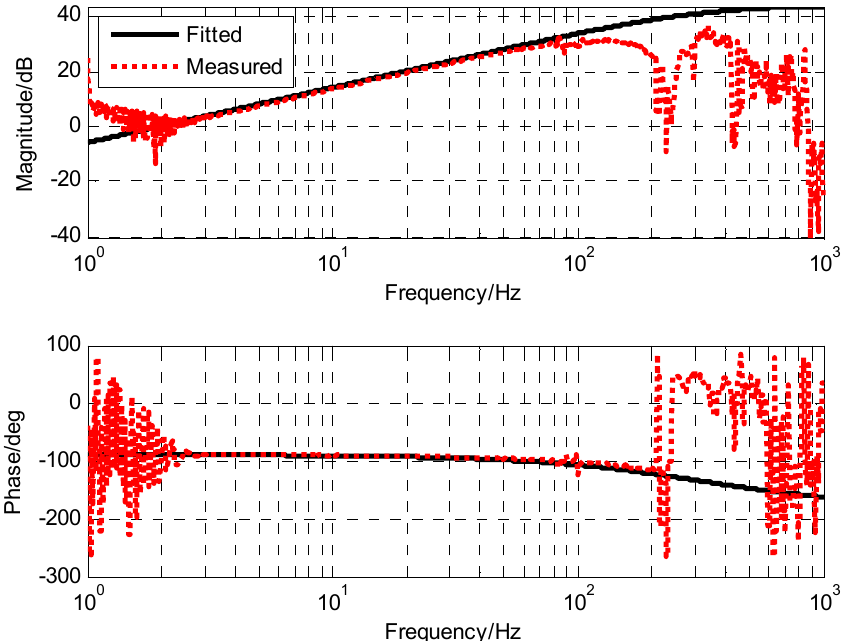
Figure 10. The frequency characteristic of MEMS accelerometers (PSD as reference sensor, one integration).